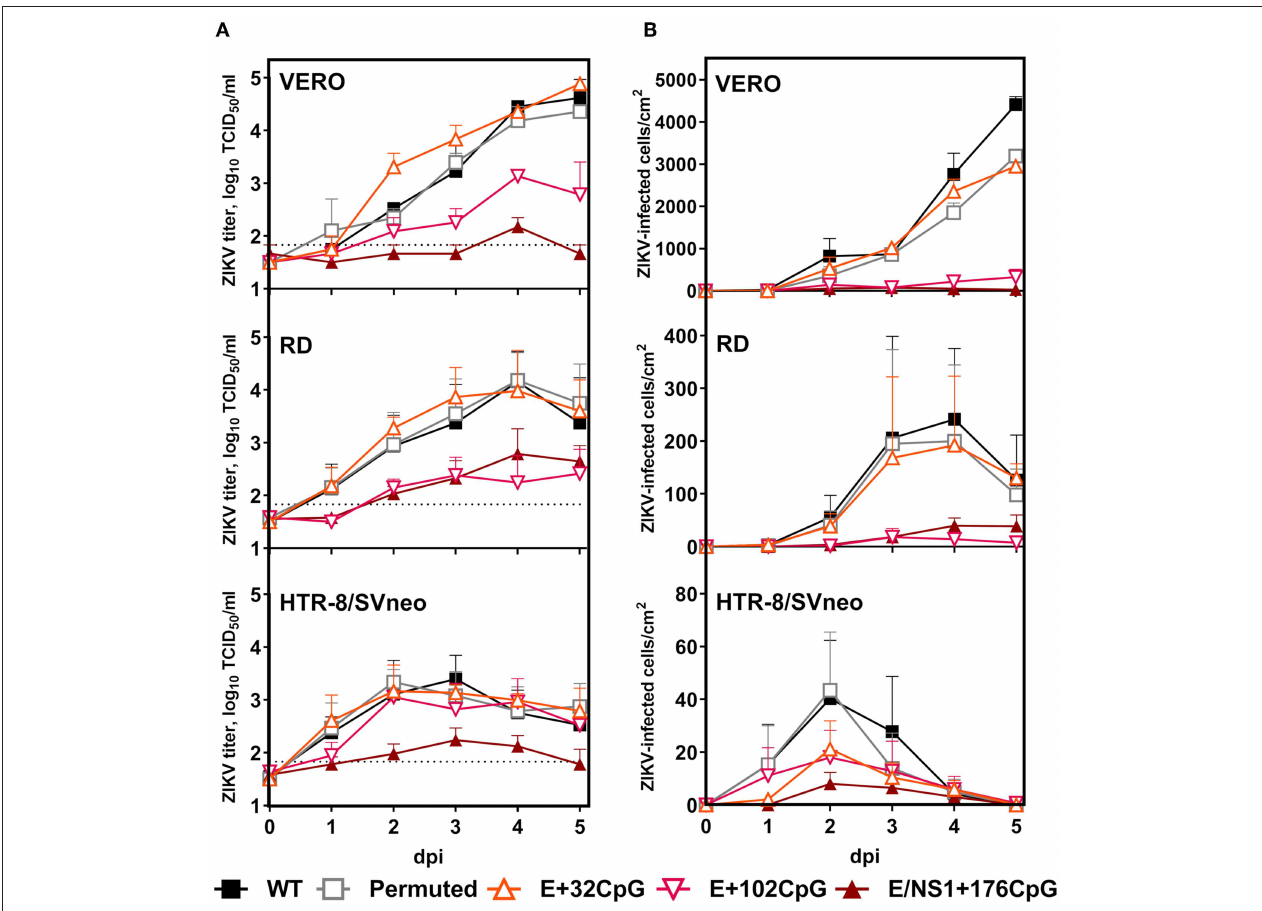
FIGURE 3 | Virus infection kinetics in VERO, RD, and HTR-8/SVneo cells after inoculation at a MOI of 0.01. (A) Cell culture supernatants were collected and viral titers were measured using the endpoint dilution assay. The dotted horizontal line represents the limit of detection (LOD). (B) The 96-well plates with cell monolayers were stained with ZIKV-specific Abs and infected cells were counted in the whole well with bright-field microscopy at 200x ( Figure 4 ). Whiskers represent standard error of the mean (SE) from three biologically independent replicates with three (two for virus titrations) technical replicates. “dpi:” days post inoculation. Dunnett’s test showed multiplicity-adjusted statistically significant p -values for E + 102CpG ( p = 0.047, the number of ZIKV-infected RD cells) and E/NS1 + 176CpG ( p = 0.014, ZIKV titers on HTR-8/SVneo; p = 0.019, ZIKV titers on VERO cells; and p = 0.020, ZIKV-infected VERO cells) vs. WT. partially outcompeted by the Permuted and WT ZIKV variants ( Table 3 ). Wild-type and Permuted variants showed comparable replication